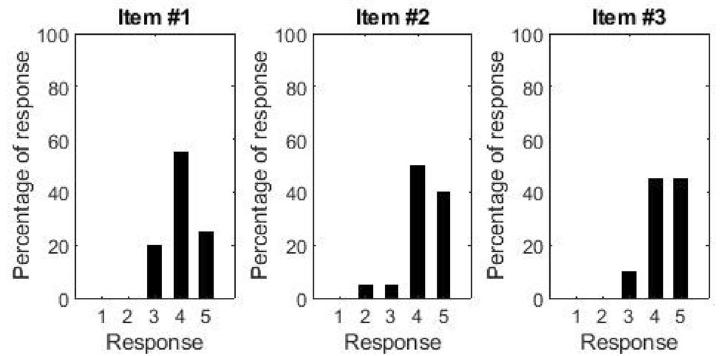
Figure 8. Histograms showing the distribution of responses to the questions about the galley.